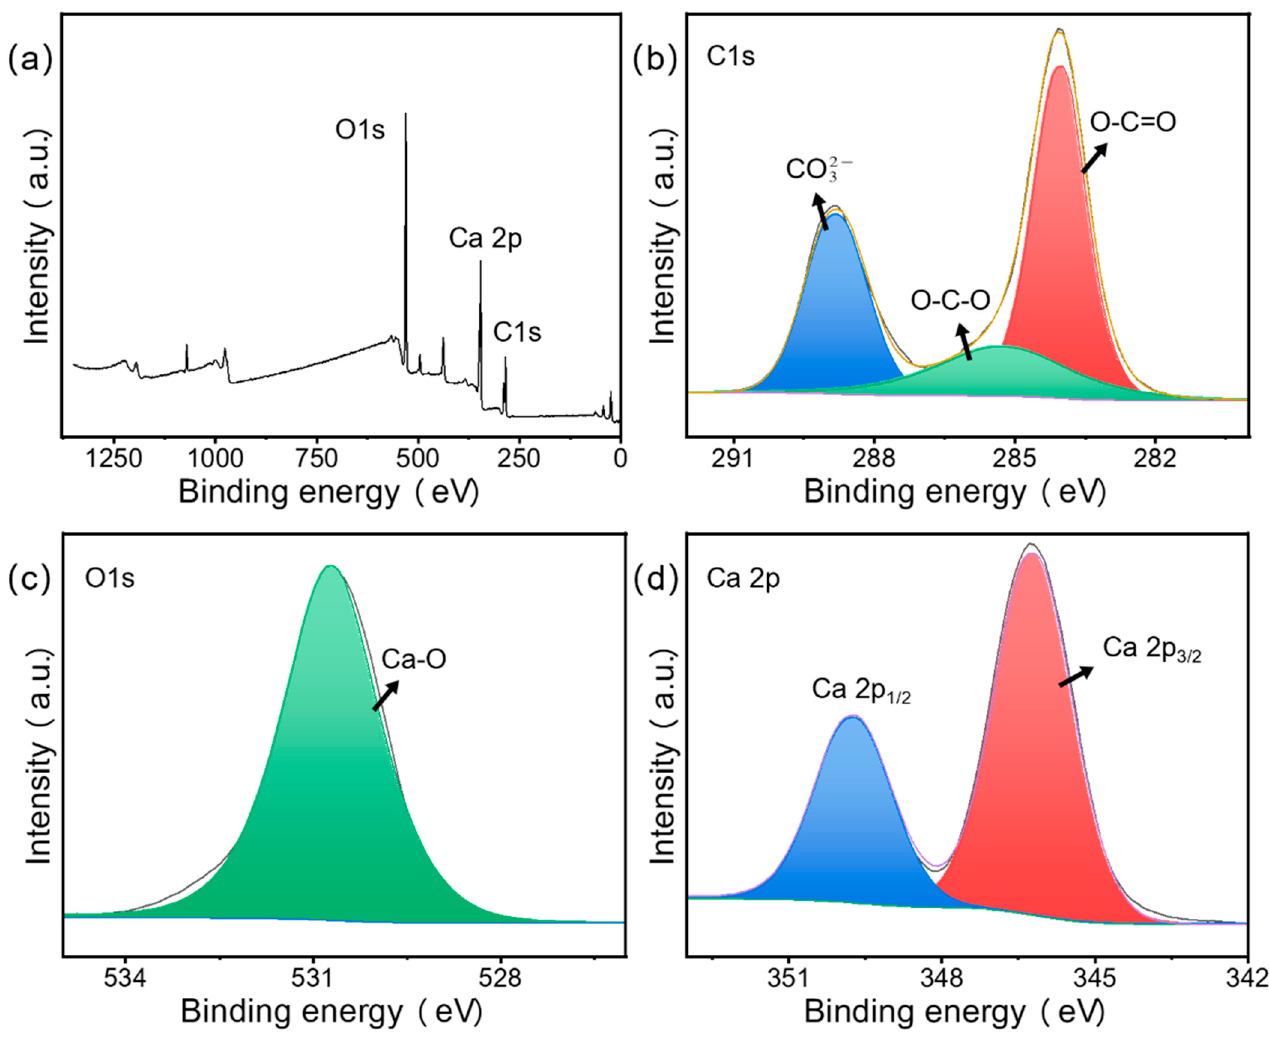
Figure 9. XPS full spectra of ( a ) SS, ( b ) C 1s, ( c ) O 1s, and ( d ) Ca 2p.